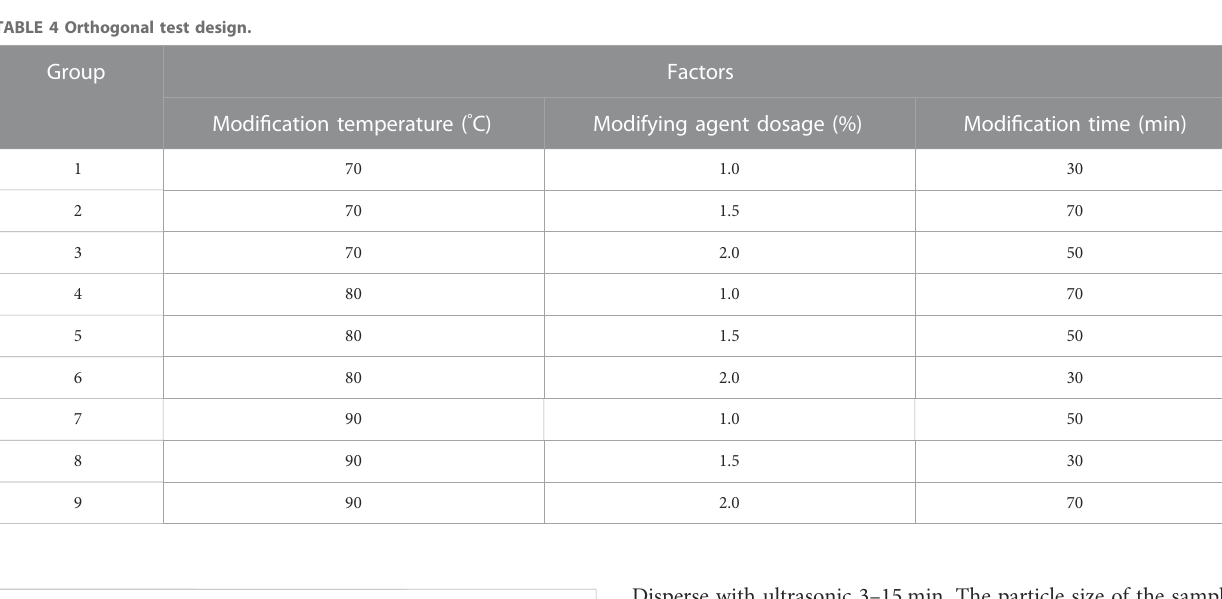
TABLE 4 Orthogonal test design.